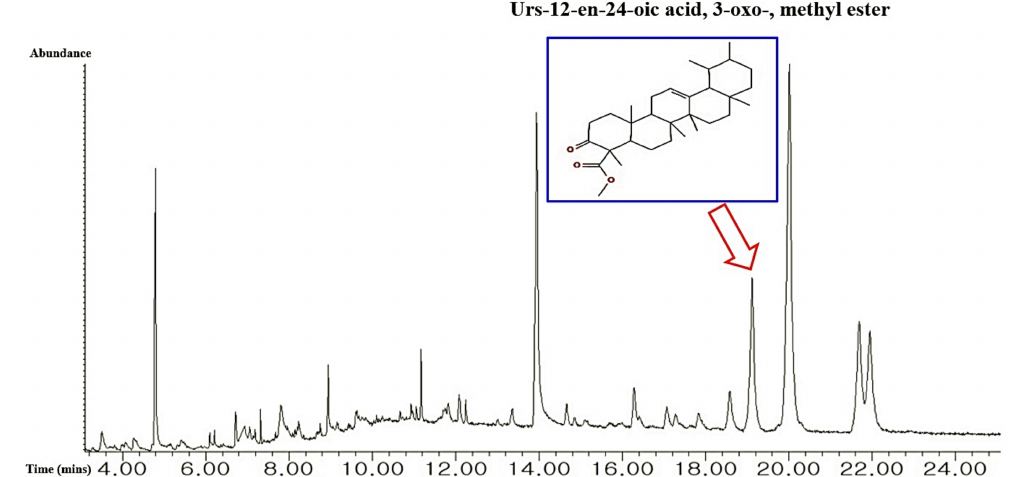
Figure 2. GC-MS peak of the C. maackii flower MeOH extract and an indication of the uppermost